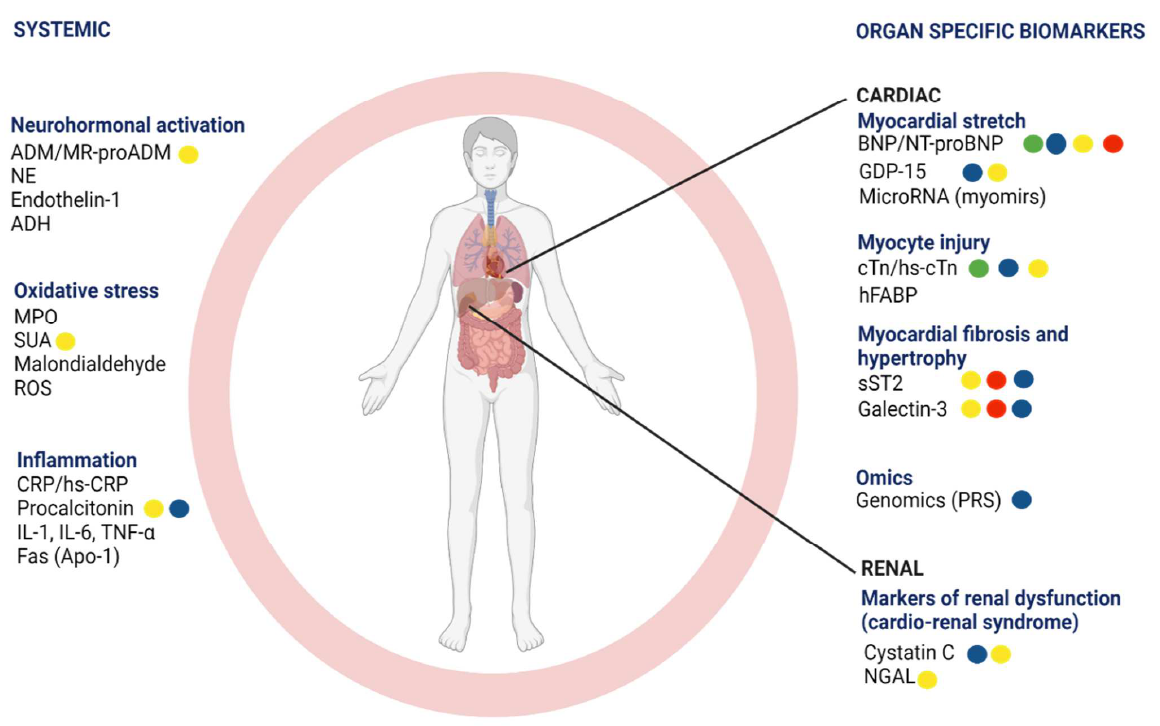
Figure 1. Biomarkers involved in various pathophysiological pathways of heart failure and their potential clinical uses. The green circle refers to biomarkers used for screening, the blue circle for phenotyping, the yellow circle for prognosis and risk stratification, and the red circle refers to